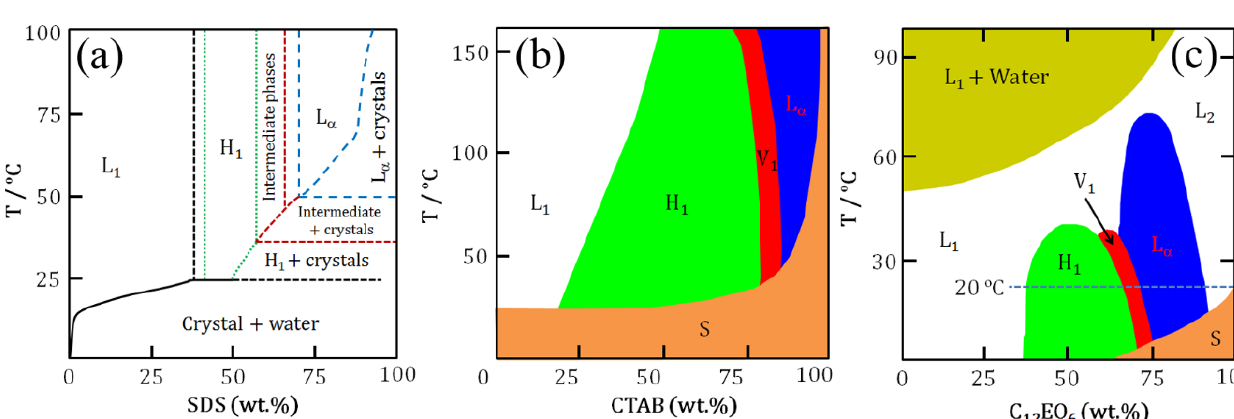
Figure 2. Schematics of aqueous binary phase behaviour: ( a ) SDS; ( b ) CTAB; and EO . Symbols correspond to phases as mentioned in Figure 1. S denotes solid ( c ) C 12 6 phase